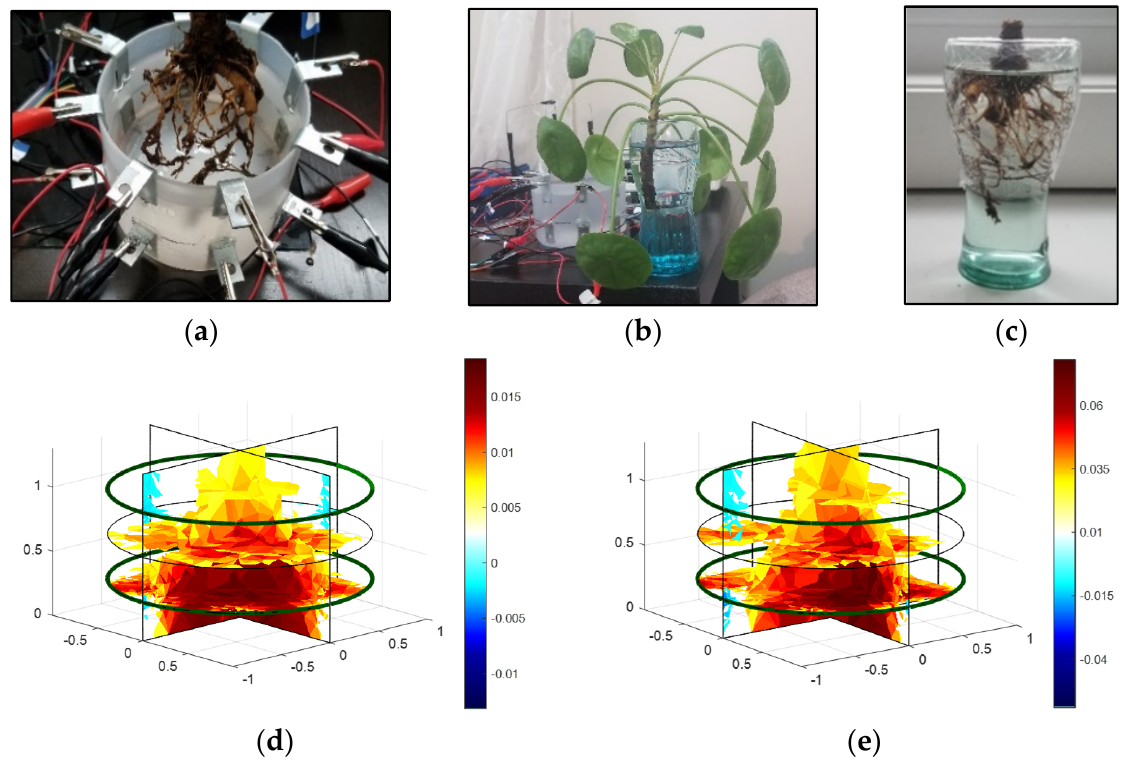
Figure 20. 3D imaging of a Pilea root in a cylindrical domain using EIT measurements and considering GN: NOSER inverse algorithm ( λ = 2.17). ( a ) Measuring root impedance, ( b ) Chinese money plant (Pilea), ( c ) Pilea root, and the reconstructed root images at 1 mA for ( d ) 5 kHz (2 Vpp), and ( e ) 80 kHz (0.4 Vpp), respectively. An improved conductivity of the root was found by increasing the frequency.